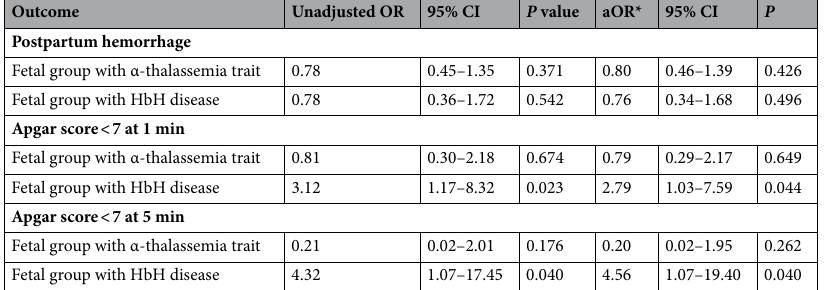
Table 3. Unconditional binary logistic regression analysis of pregnancy outcomes with thalassemic women whose fetuses were normal as the reference group. *Adjusted for maternal age, gravidity, parity, ethnic group, gestational weeks at first visit, number of prenatal visits, residency in Guangxi province or fetal